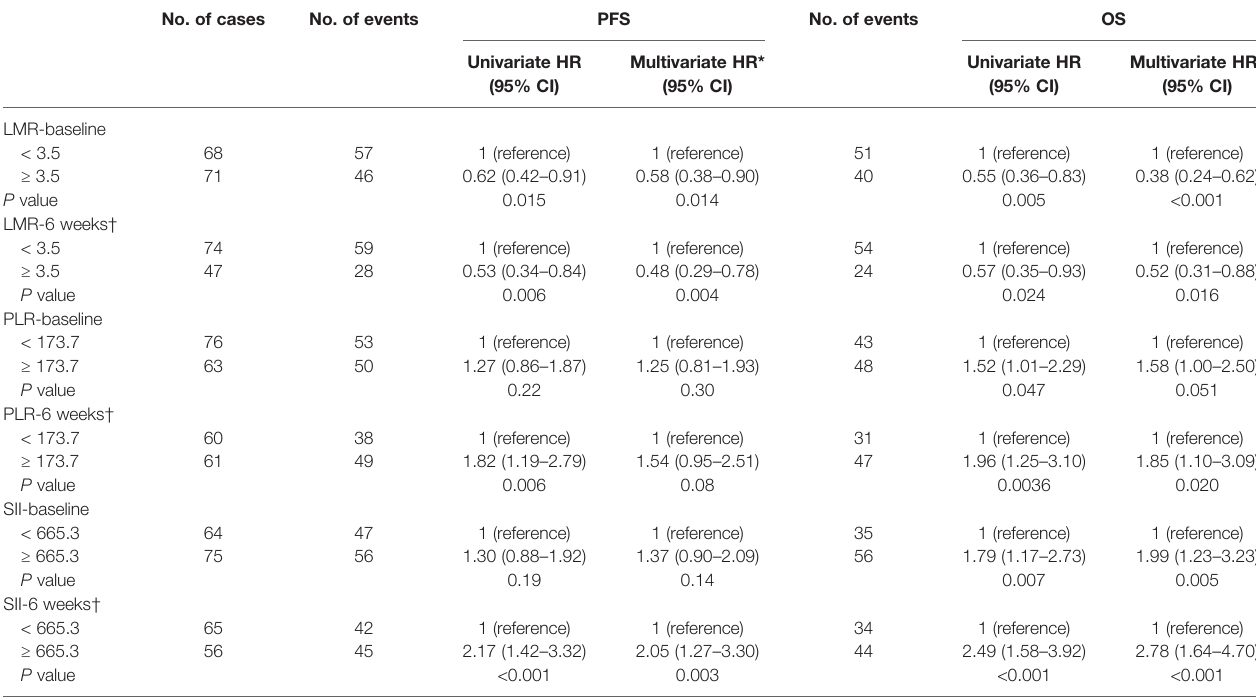
TABLE 2 | Association of LMR, PLR, SII at baseline, and at week 6 (± 2 weeks) with survival in multivariable Cox regression models in advanced gastric cancer patients. No. of